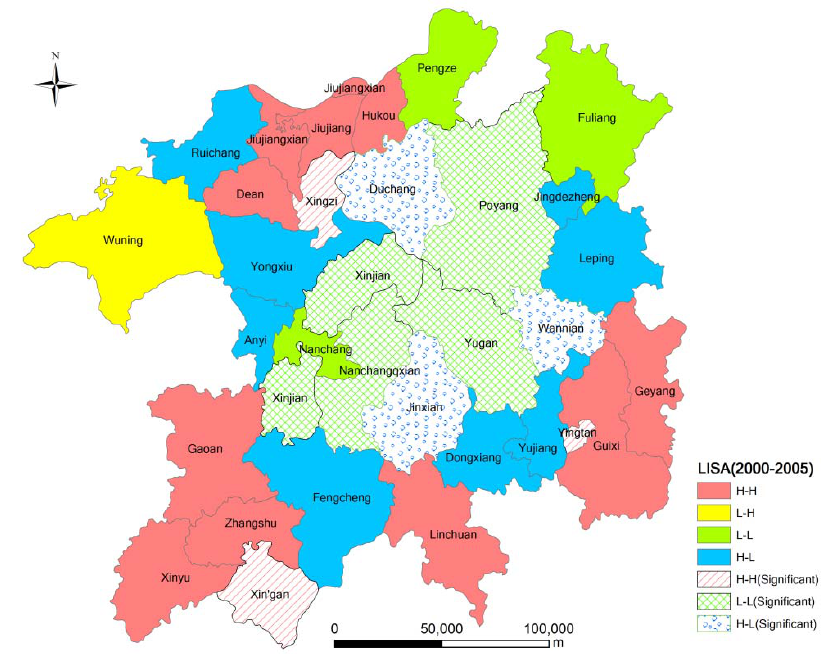
Figure 4. LISA clustering of ecological land change in the Poyang Lake Eco-economic Zone during 2000–2005 at the county